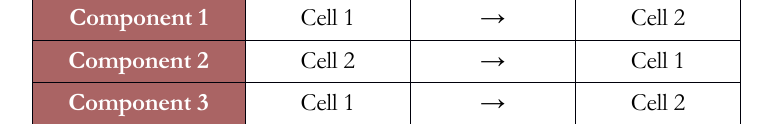
Table 5. Process sequence of the components